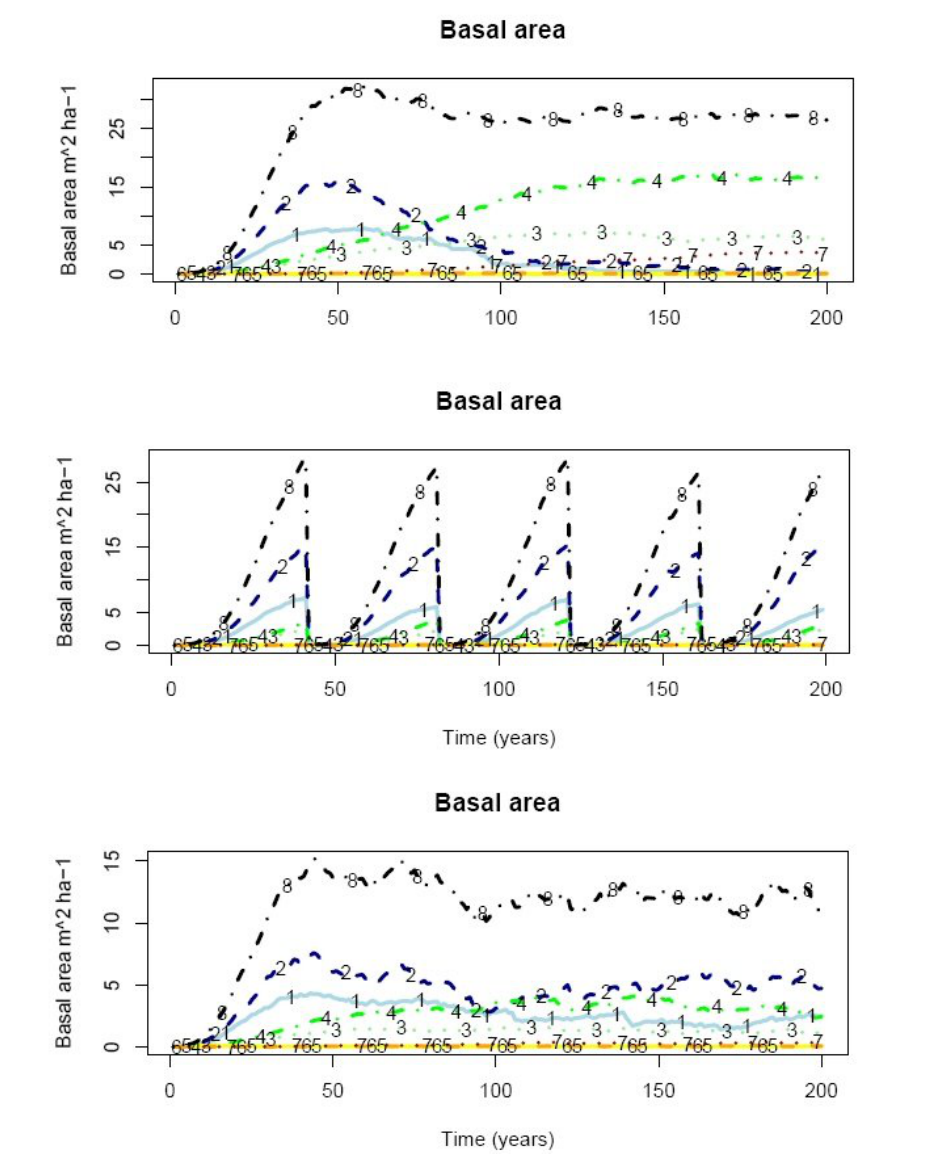
Fig. 5. Dynamics of forest structure and composition following human disturbance. The graphs present results from simulations produced by an individual tree-based gap model parameterized for montane forests in Chiapas (Golicher 2001). Three disturbance regimes were simulated, following clearcutting of a patch of forest (to simulate traditional land-use practices): (a) no subsequent disturbance, (b) recurrent disturbance caused by slash-and-burn agriculture, and (c) recurrent disturbance caused by timber and fuelwood harvesting. Numbers refer to different tree species; 1: Pinus oocarpa 2: Pinus maximinoi 3: Quercus segoviensis 4: Quercus crispipilis 5: Heliophilic shrubs 6: Understorey 7: Generic broadleaf 8: Total. Note the slow recovery of late-successional, broadleaved species